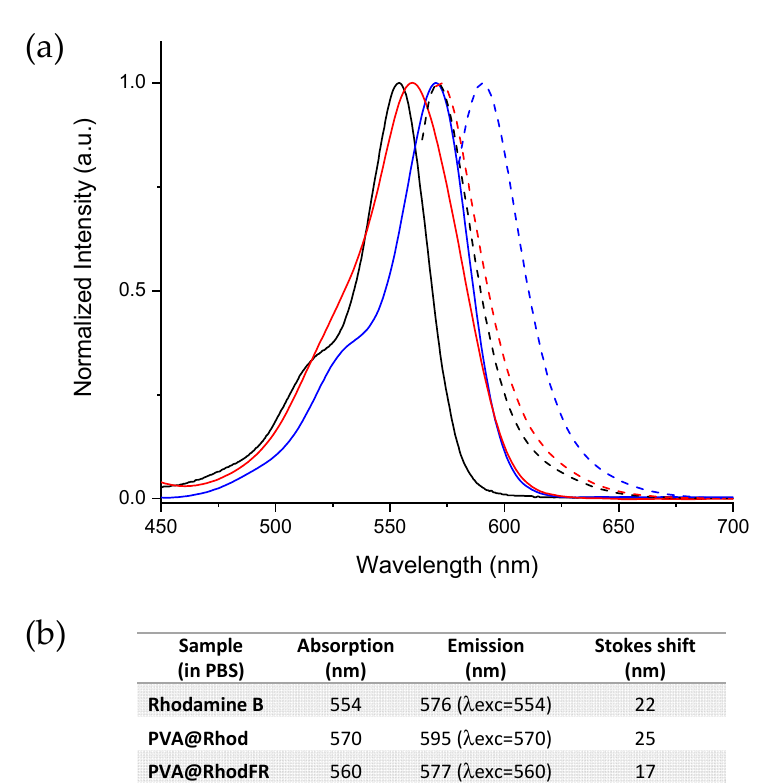
Figure 5. ( a ) Solid lines, normalised UV-Vis spectra for water solutions of rhodamine B (black), PVA@Rhod (blue), and PVA@RhodFR (red). Dashed lines, normalised fluorescence spectra for water solutions of rhodamine B (black, λ exc = 554 nm), PVA@Rhod (blue, λ exc = 570 nm), and PVA@RhodFR (red, λ exc = 560 nm). ( b ) The absorption and emission wavelengths of the samples, and the related Stokes shift.